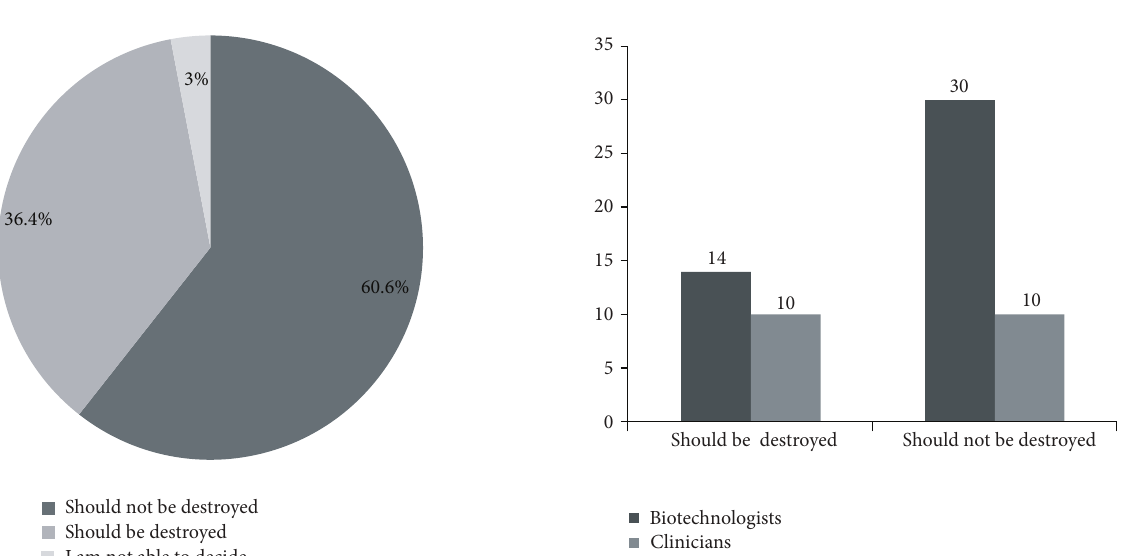
Figure 1: The verdict: to destroy the virus or not. The Pie diagram depicts the opinions of participants on the destruction of remaining variola virus stocks. Majority voted in favour of continued preserva- tion (60.6%).